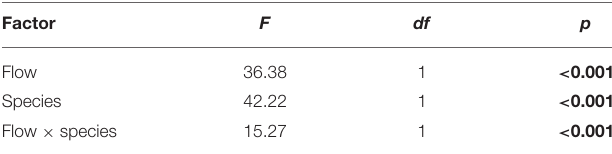
TABLE 1 | ANOVA summary for effects of flow and species on photosynthesis of Favites and P. damicornis .